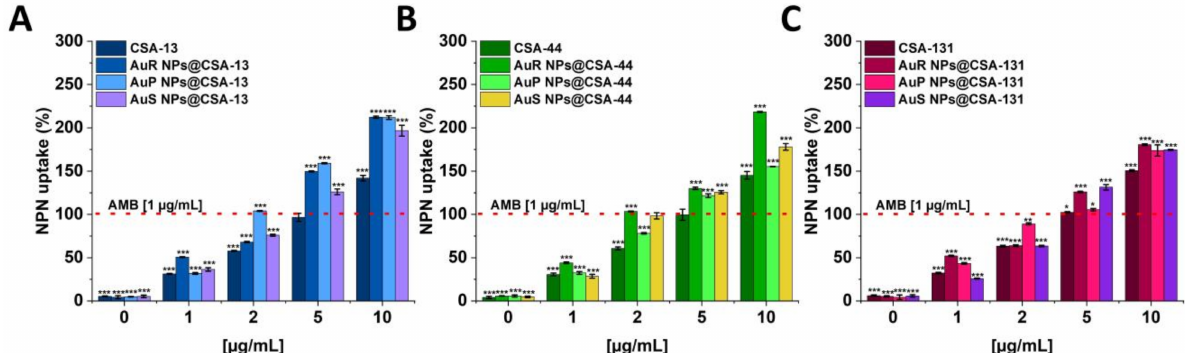
Figure 7. The increase of the membrane permeability of C. albicans 1408 subjected to CSA-13, AuR NPs@CSA-13, AuP NPs@CSA-13, AuS NPs@CSA-13 ( A ); CSA-44, AuR NPs@CSA-44, AuP NPs@CSA-44, AuS NPs@CSA-44 ( B ); and CSA-131, AuR NPs@CSA-131, AuP NPs@CSA-131, AuS NPs@CSA-131 ( C ) at doses of 1–10 µ g/mL was investigated using the fluorimetric method. The dashed line corresponds to the effect obtained with the amphotericin B at a concentration of 1 µ g/mL. The results show the mean ± SD, n = 3; * indicates statistical significance at ≤ 0.05, ** ≤ 0.01, and *** ≤ 0.001.